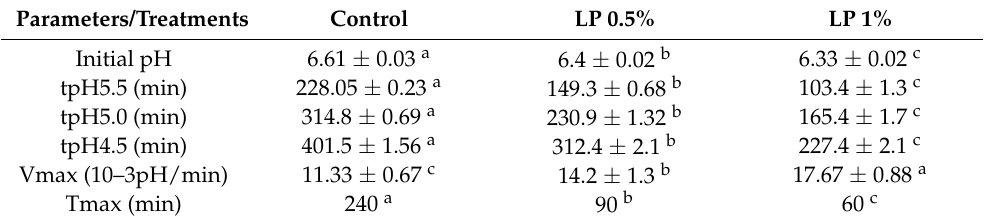
Table 1. Effects of PFPP addition at various concentrations on the fermentation kinetics of labneh.